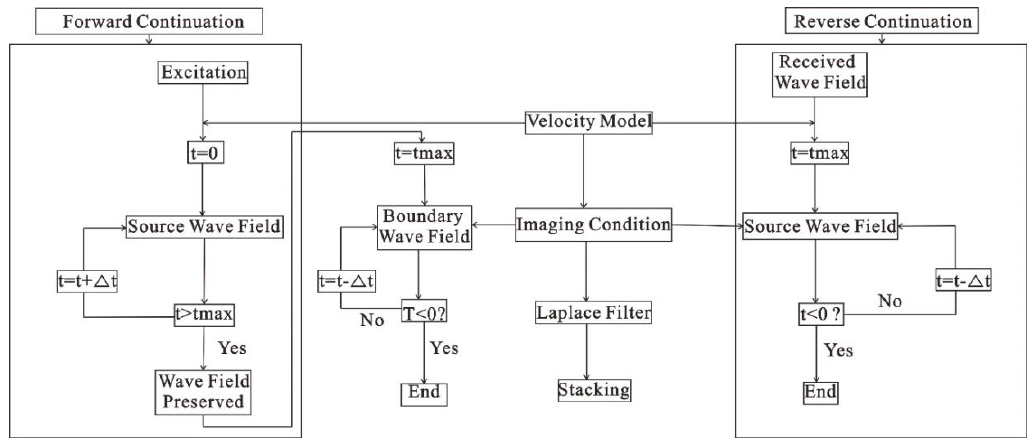
Figure 2. The realization process of reverse time migration (RTM) algorithm.